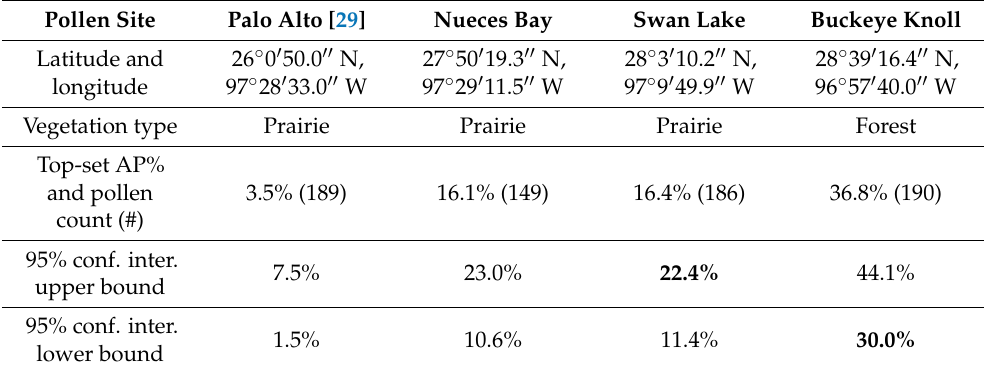
Table 8. Present vegetation types and Modern AP levels defining the forest–prairie ecotone; 95% confidence interval boundaries used to establish forest–prairie ecotone (AP% band) are in bold .